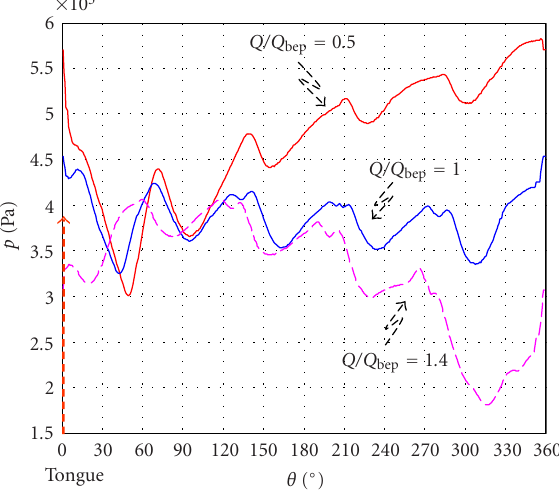
Figure 21: Static pressure distribution at the impeller periphery, for di ff erent pump capacities ( α = 0 ◦